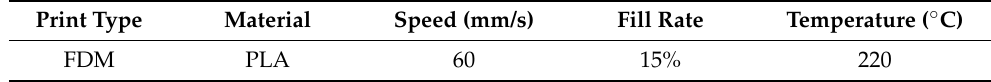
Table 4. Process parameter table for the printing molding experiment.